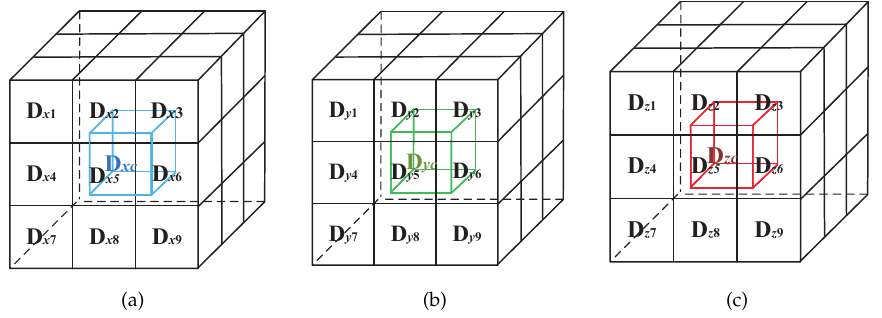
Figure 4. ( a ) the distribution of the pixel in the center of I x and surrounding pixels; ( b ) the distribution of the pixel in the center of I y and surrounding pixels; ( c ) the distribution of the pixel in the center of I z and surrounding